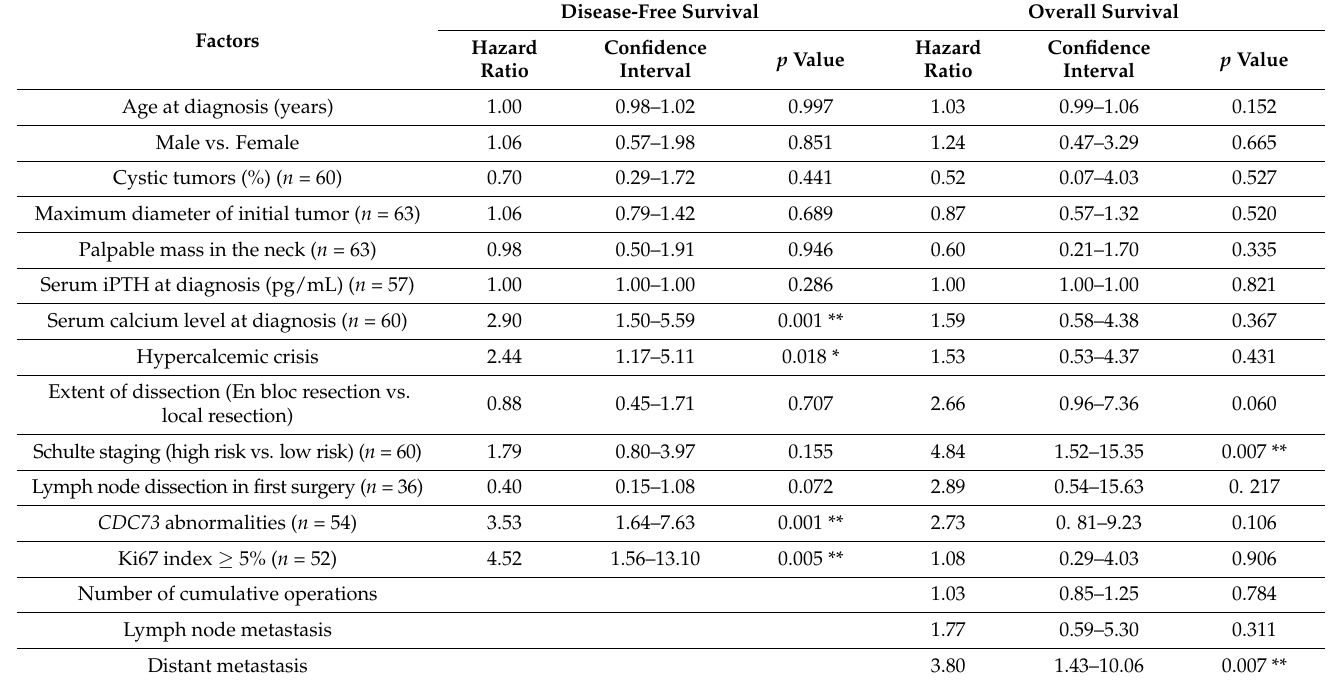
Table 2. Risk factors for the disease-free survival and overall survival outcomes of PC patients in the univariate Cox proportional hazard